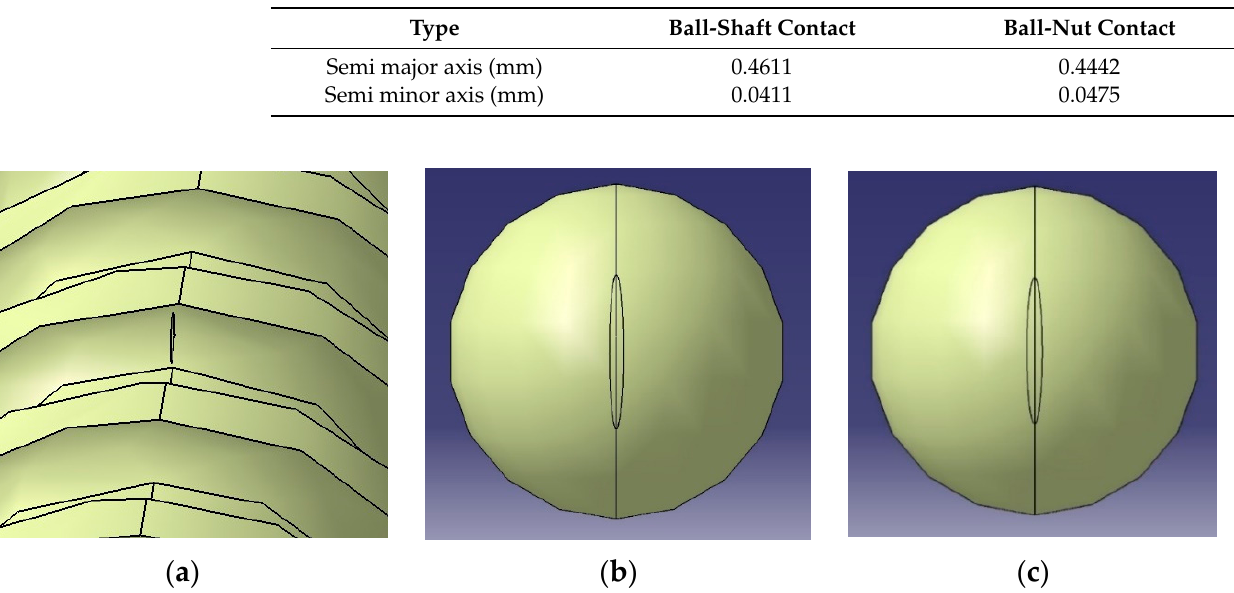
Table 4. Parameters of contact ellipse.